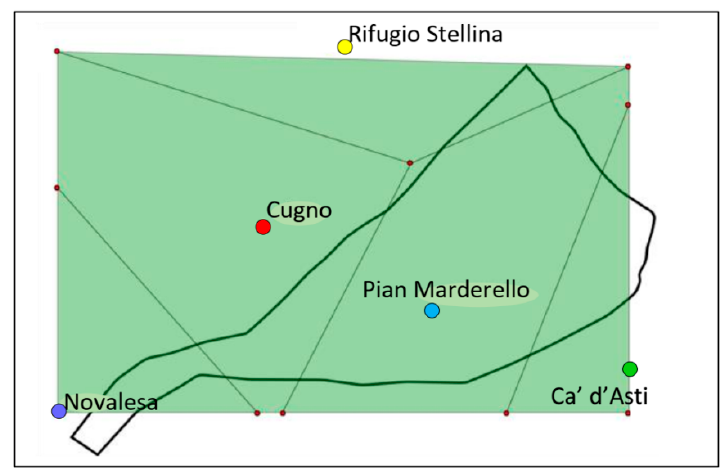
Figure A2. Thiessen’s (Voronoi) polygonization of the Marderello’s basin.